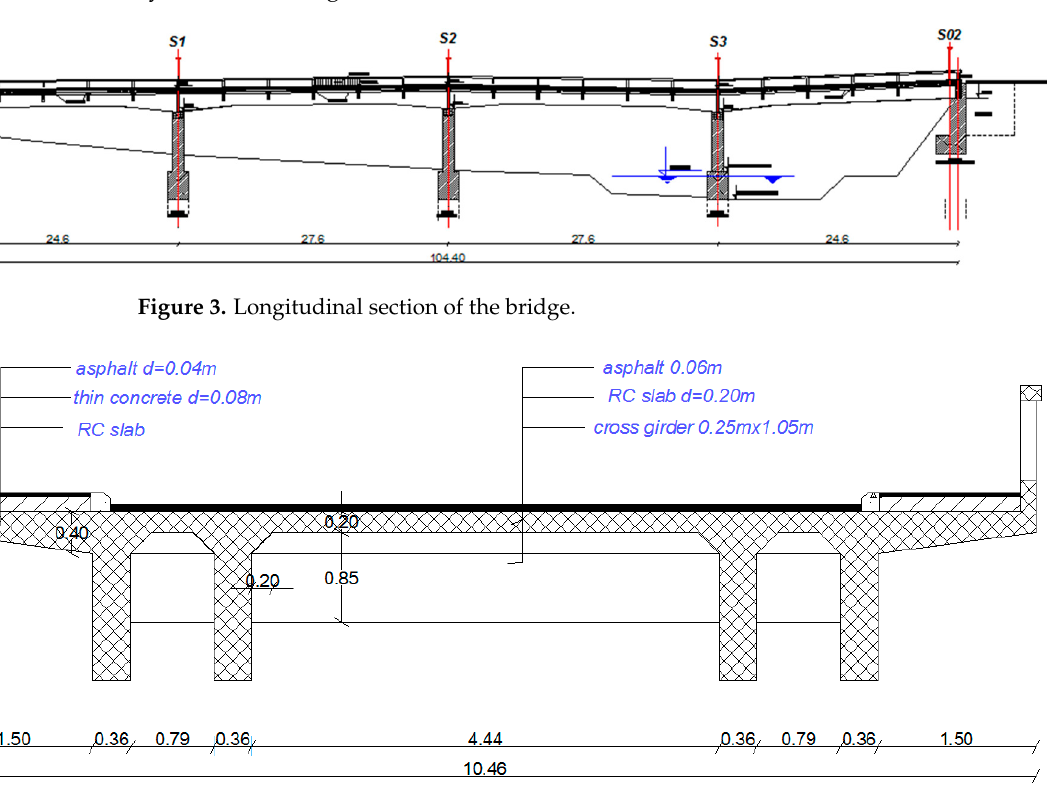
Figure 4. Bridge deck cross-section in the middle of the spans.